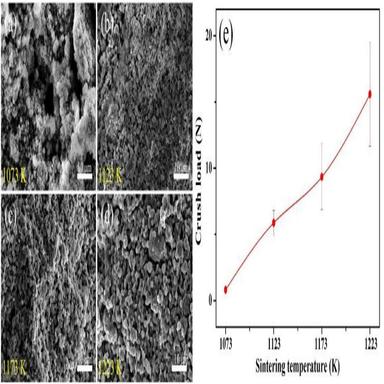
SEM fracture morphology and crush load of the pebbles sintered at various temperatures in vacuum.